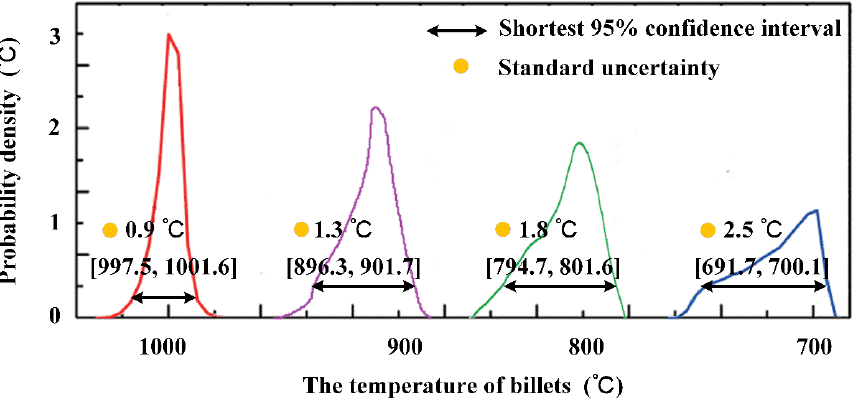
Figure 10. PDFs of the temperature of billets calculated from 10 5 Monte Carlo method at 700 – 1000 °C.